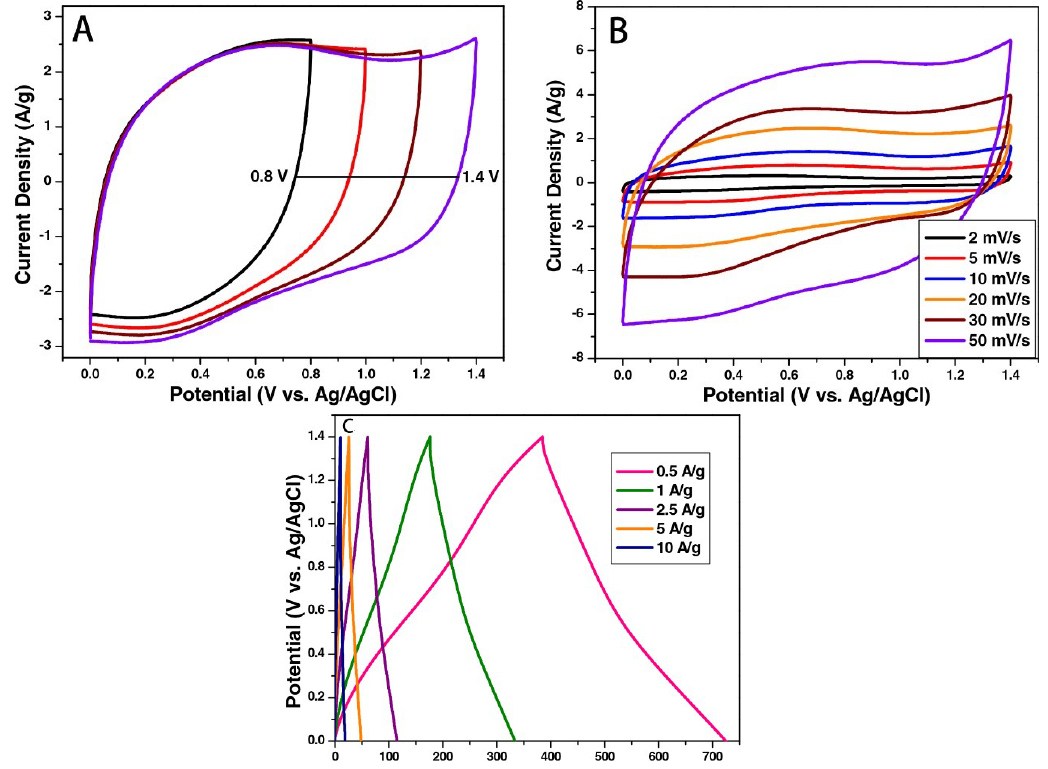
Figure 5: The electrochemical properties of the device were tested using two-electrode system for the CFF/MnO 2 composite that synthe- sized with 4 h reaction time. (A) CV curves of the device collected in different scan voltage windows, (B) CV curves at different scan rate,